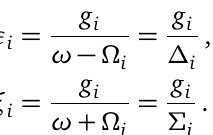
. The qubit and the qudit are coupled 2 1,2